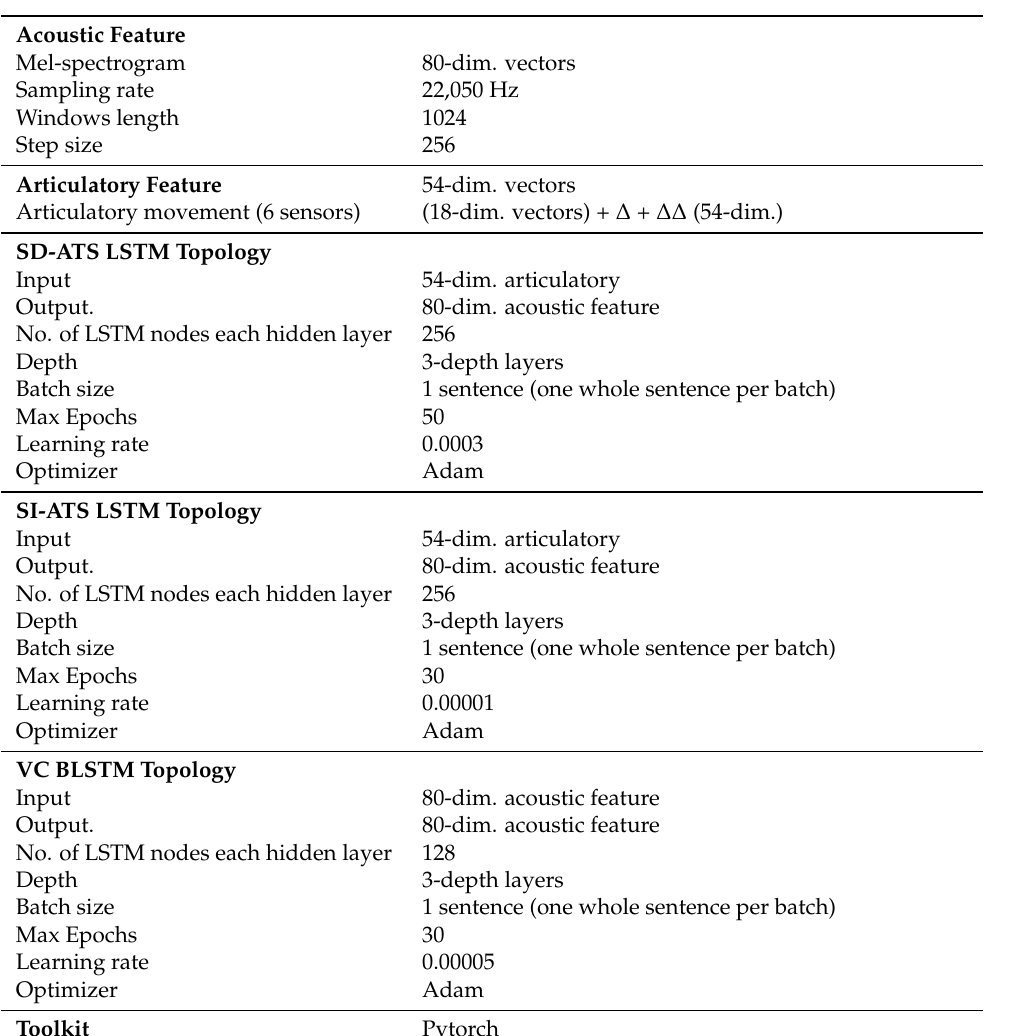
Table 2. Topologies of the neural networks in this